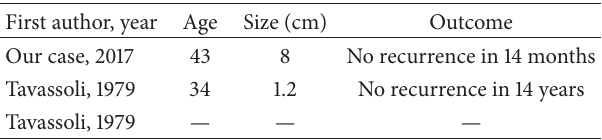
Table 1: A summary of the epithelioid leiomyoma cases of nonuter- ine gynecological